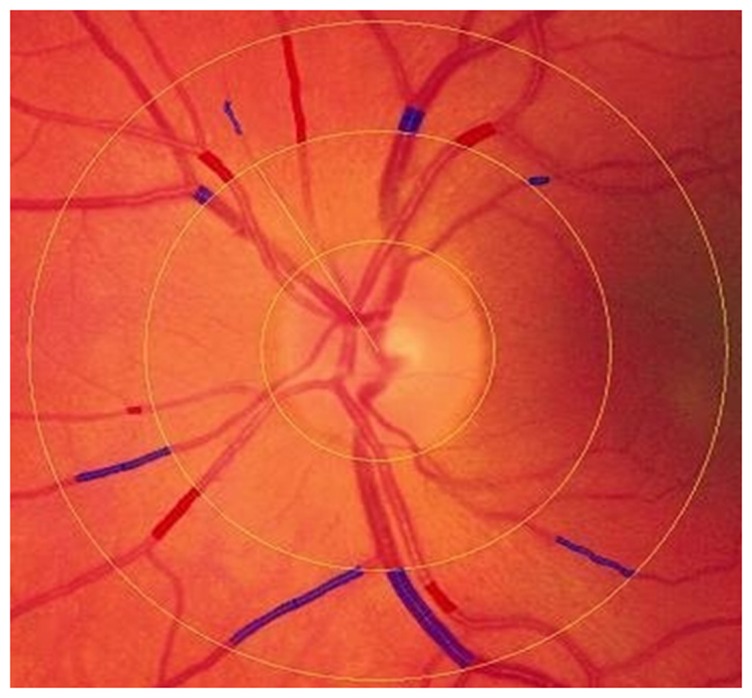
Digital photograph a MESA participant's retina showing central retinal vascular caliber.The caliber of retinal vessels is a calculated average of measurements of all arterioles and venules coursing through an area one half to one full disc diameter from the optic disc margin. Red shaded areas are used to compute the central retinal artery equivalent (CRAE) and blue shaded areas are used to compute the central retinal vein equivalent (CRVE).